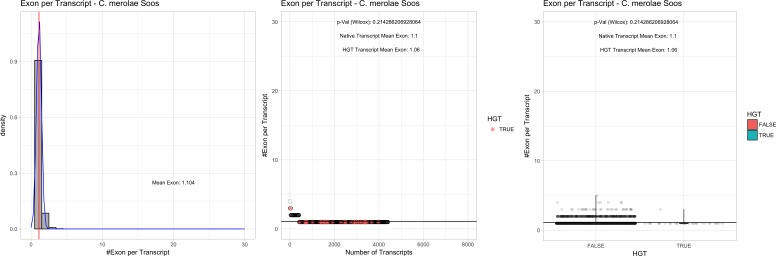
Exon/Intron – Cyanidioschyzon merolae Soos: (Left) Mid) Cumulative %GC distribution of transcripts.Red line shows the average, blue line a normal distribution based on the average value. The data is categorical (genes have either one, two, three etc. exons) and does not follow a normal distribution. (Mid) Ranking all transcripts based upon their number of exons. Red ‘*” demarks HGT candidates. As the number of exons was not normally distributed, transcripts were ranked by number of exons. In order to resolve the high number of tied ranks (e.g. many transcripts have two exons) a bootstrap was implied by which the rank of transcripts sharing the same number of exons was randomly assigned 1000 times. Wilcoxon-Mann-Whitney-Test applied for the determination of significant rank differences between the native gene and the HGT candidate subset. (Right) Violin plot showing the number of exons per transcript distribution across native transcripts and HGT candidates..